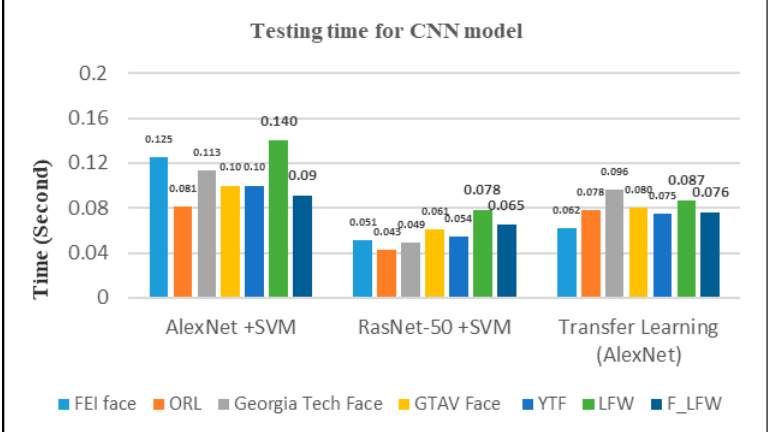
Figure 13. Testing time for convolutional neural network models.